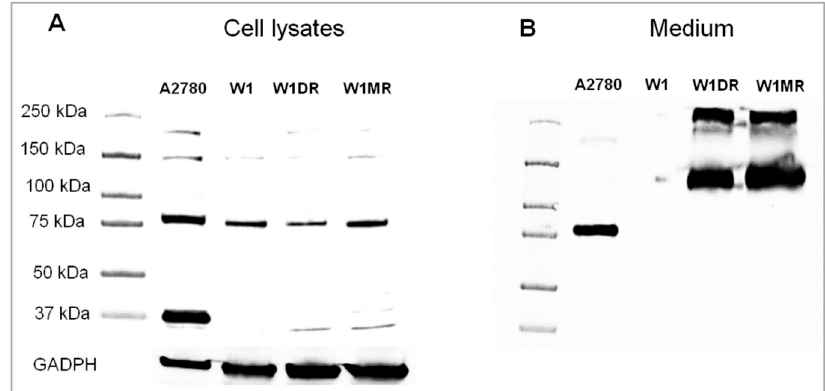
Figure 3. OSF-2 protein expression analysis in: ( A ) cell lines: for A2780—the most intensive bands with masses of 37 and 85 kDa; for W1, W1DR, and W1MR—one prevalent band with a mass of 85 kDa, and ( B ) corresponding media: for A2780—one distinctive band with a mass of 85 kDa; for W1DR and W1MR—highly intensive bands of about 120 kDa and over 250 kDa. The cellular proteins and proteins isolated from the media were separated using 7% PAGE and transferred to a PVDF membrane, which was then immunoblotted with either primary Ab or HRP-conjugated secondary Ab. A primary anti-GADPH Ab was used as a loading control for the cell lysates.